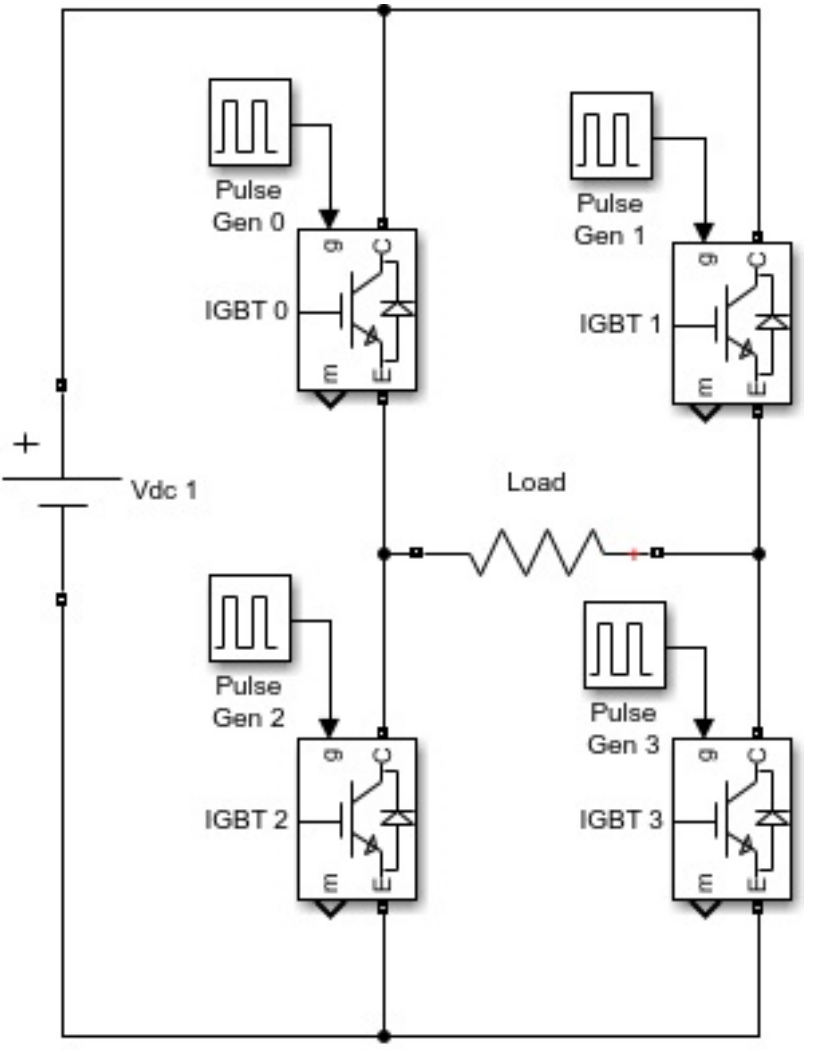
Figure 1. Structure of H-bridge.